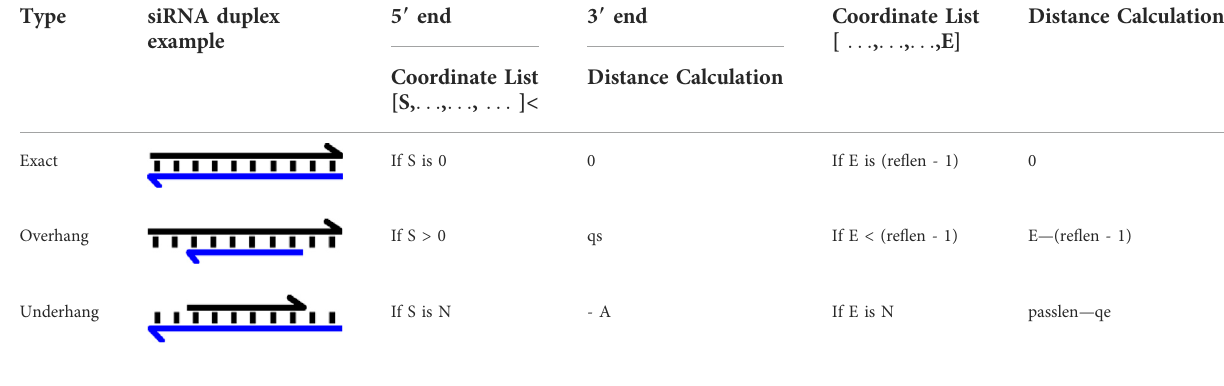
TABLE 1 The stepRNA methodology for calculating the distance between a reference strand and the passenger strand.